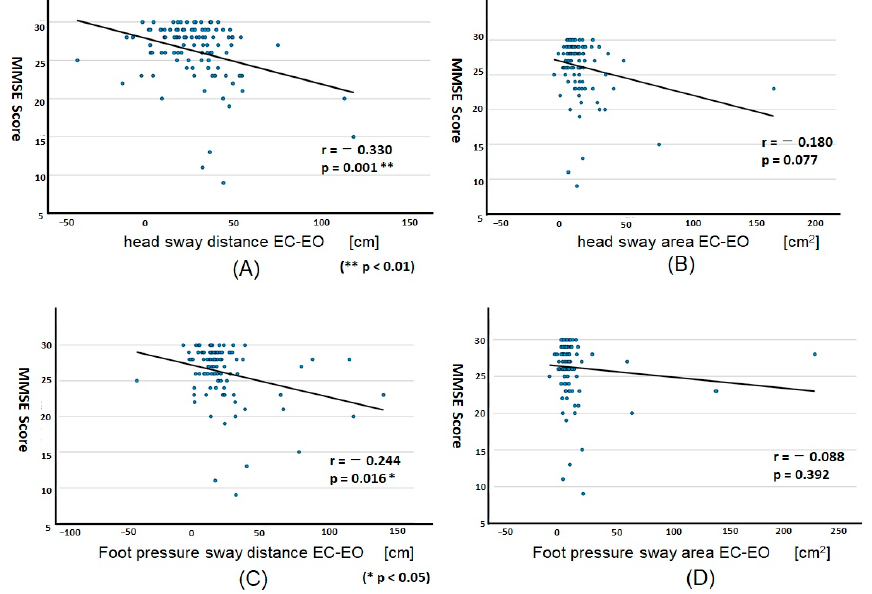
Figure 3. Correlation plotting between MMSE score and sway test results standing on two legs by EC-EO. Sway tests were performed when individuals were standing on two legs in EC and EO ( n = 103), and the difference between EC and EO was obtained. The correlation was plotted for the head sway distance ( A ) and area ( B ), the foot pressure sway distance ( C ) and area ( D ). Note that a significant correlation was found in the head ( A ) and foot pressure sway ( C ).